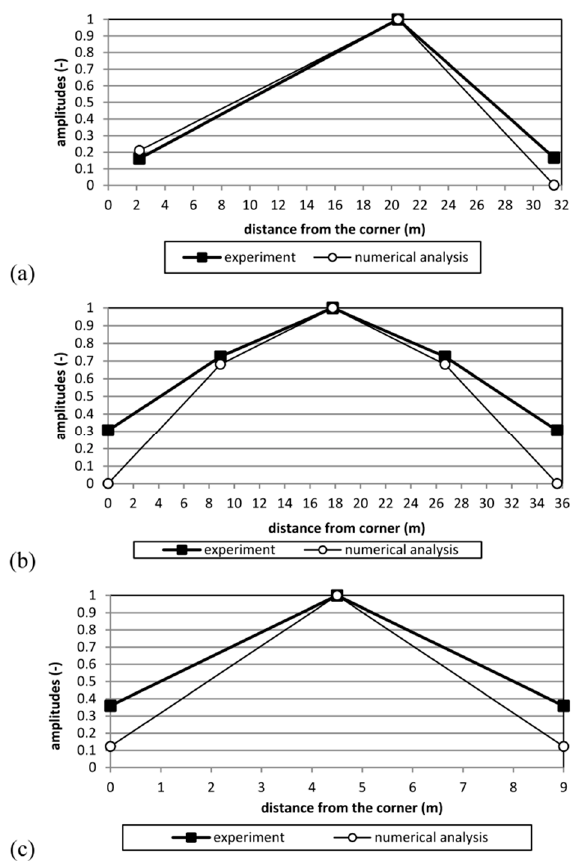
Figure 13. Comparison of the mode shape between the experiment and numerical analysis: ( a ) Otaru warehouse, east wall, Matsumoto storehouse, north wall ( b ) and west wall ( c ).